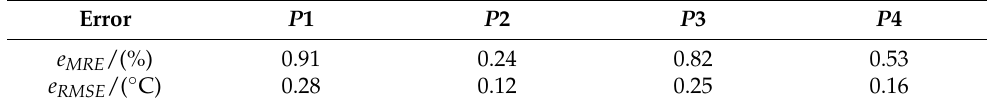
Table 1. Results of model validation.